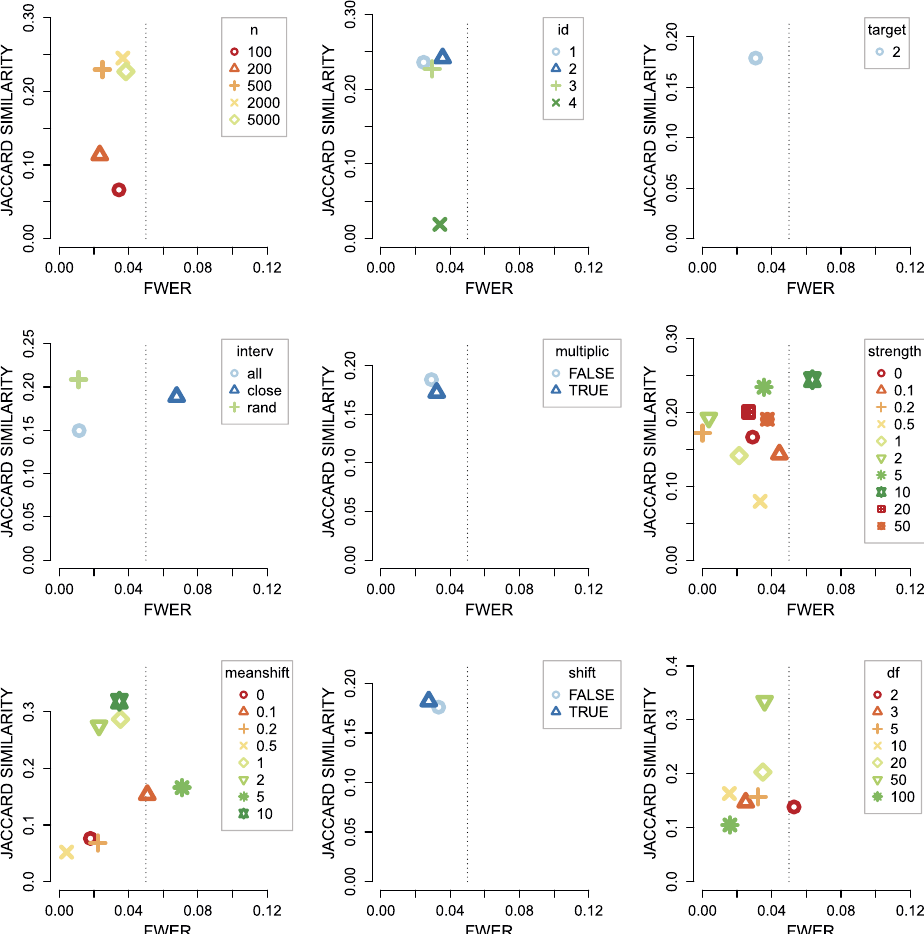
Figure 10: Average Jaccard similarity over the conditional independence tests (A)–(F) (y-axis) against average FWER (x-axis) when estimating the parents of variable 2. The figure is otherwise generated analogously to Figure